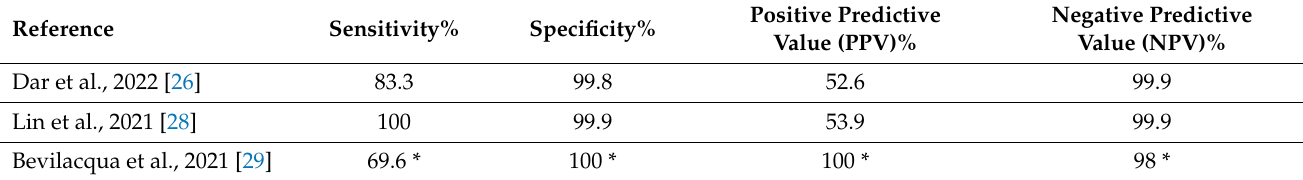
Table 2. 22q11.2 microdeletion detection by